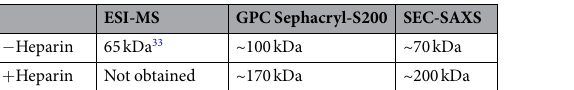
Table 2. Comparison of MW app of hIL-12 in the absence and presence of heparin using different